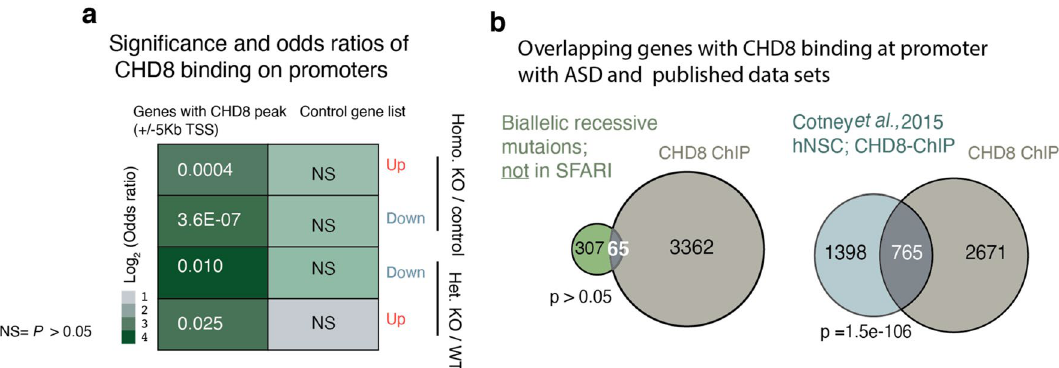
Figure 14. CHD8 binding at promoter of DE and ASD genes. ( a ) The odds ratio, strength, and significance of CHD8 binding on DEG promoters in heterozygous and homozygous CHD8 KO neurons (DE genes are obtained from RNA-seq experiment and odds ratio calculated based on overlapping gene list analysis) (GeneOverlap: http:// shenl ab- sinai. github. io/ shenl ab- sinai/). ( b ) Overlapping CHD8-bound genes in our experiment with genes that exhibit a recessive mutation in ASD and with previously published data set of CHD8 binding in human NPCs 48,49 . Significance of the overlapping calculated with the hypergeometric test.